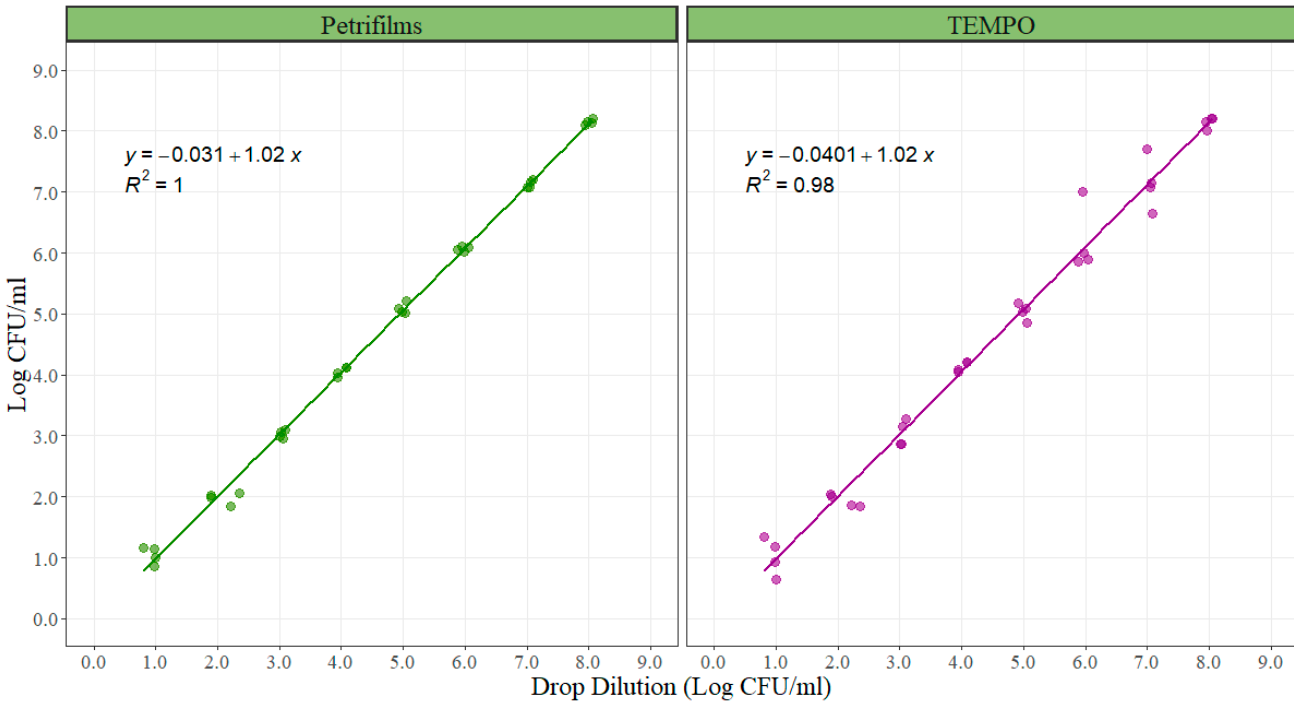
Figure 3. Graphic representation of the linear correlation between the bacterial counts of the alternative methods (3M™ Petrifilm™ and TEMPO ® system) when compared with the standard method (direct plating), (n = 32 per method).